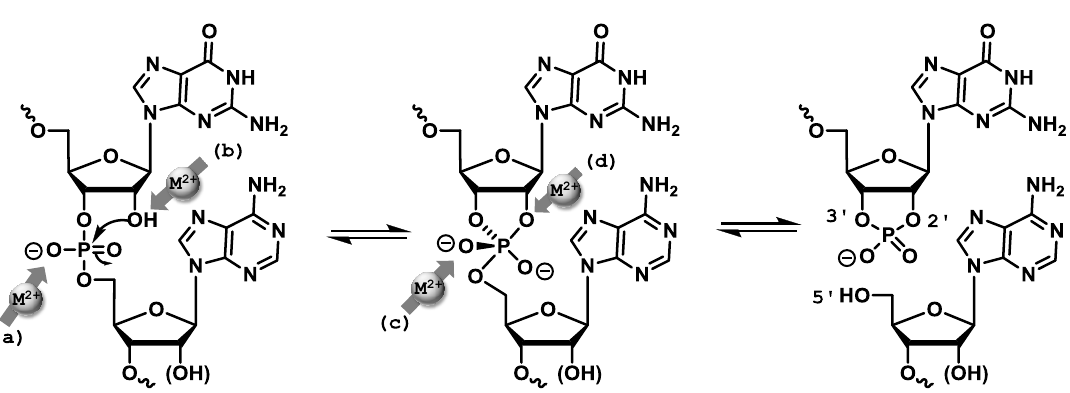
Figure 4. RNA-cleavage reaction (shown for Dz8-17) leading to the 2′,3′-cyclic phosphate and the 5′-OH products and plausible sites of interaction of the M 2+ cofactors (directly or via an activated water molecule):( a ) negative charge stabilization of a non-bridging oxygen atom or general acid catalysis; ( b ) activation of the nucleophilic hydroxyl unit by deprotonation or coordination; ( c ) stabilization of the build-up of negative charge on the oxygen atom of the leaving group; ( d ) general base catalysis [72,82,84,85]. Scheme adapted from reference [82].